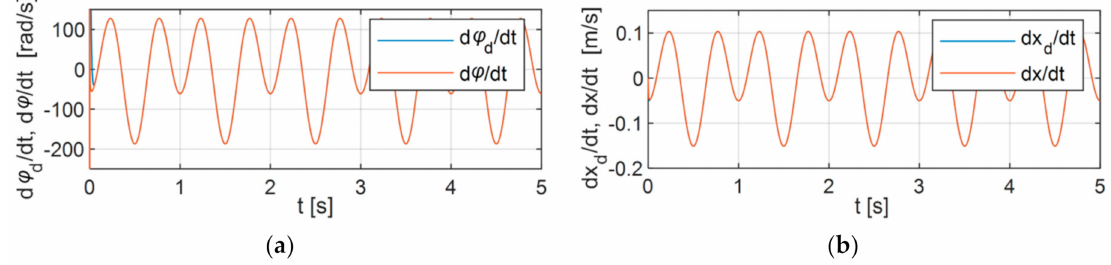
Figure 5. Trajectory: ( a ) adjusted d ϕ d / dt and realized d ϕ / dt speeds of the active part; ( b ) adjusted dx d / dt and realized dx / dt speeds of the passive part.